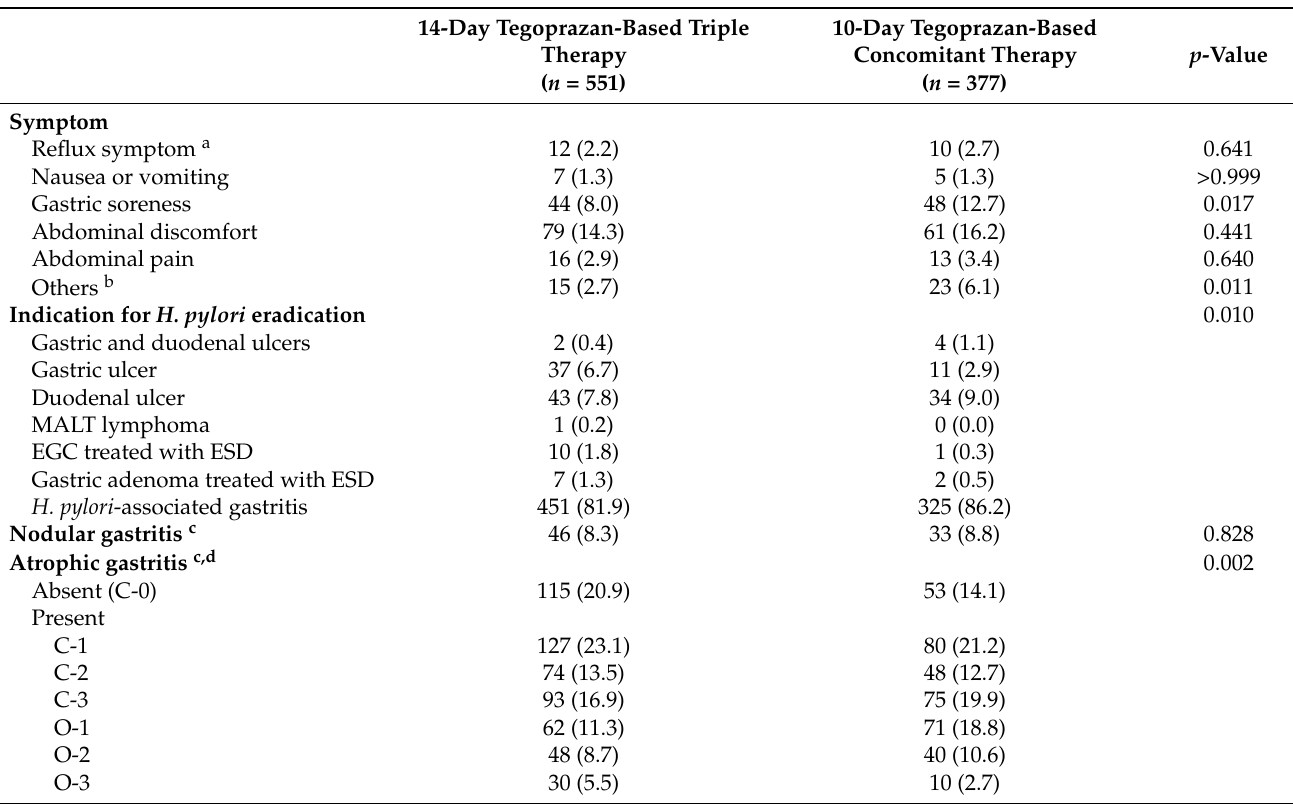
Table 2. Baseline symptoms and endoscopic